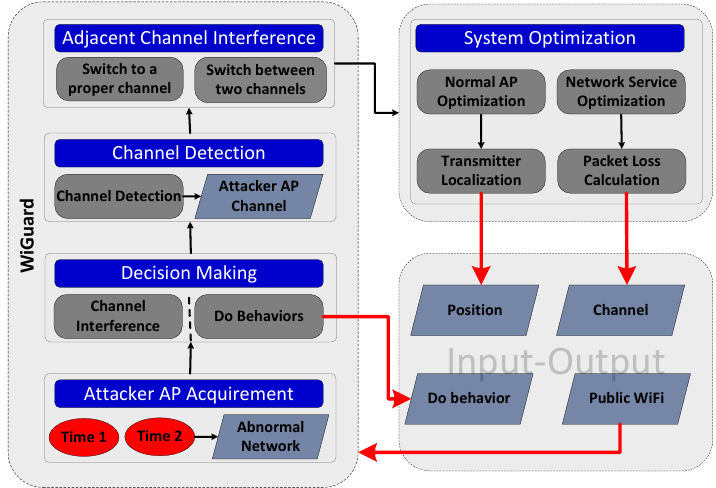
Figure 3. System